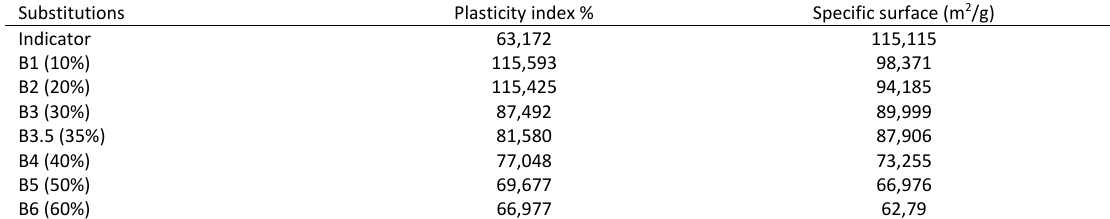
Table 2: Values of the plasticity index and specific surface of the realized mixtures